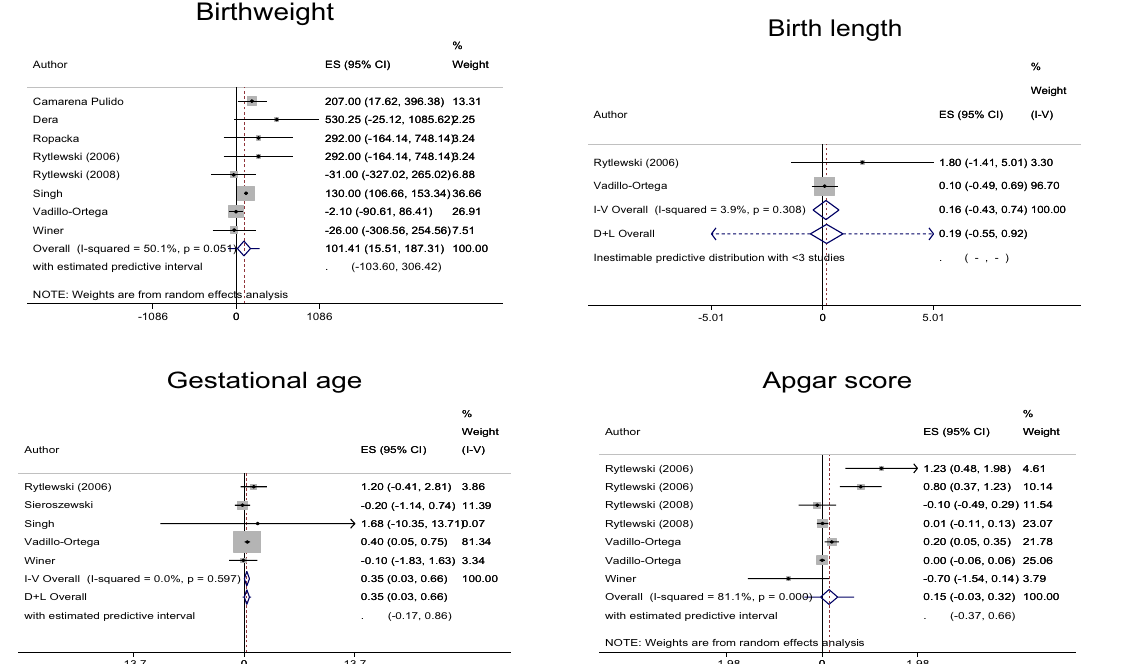
Figure 3. Forest plots of continuous birth outcomes. D + L, DerSimonian & Laird; I-V, inverse variance. The model of DerSimonian & Laird is used when D + L or I-V is not attached to ‘Overall’. In comparison to controls, the oral l-arginine groups showed significantly increased mean birthweight and gestational age ( n = 8 and 5, respectively) in the total score. However, 95% prediction intervals revealed no guarantee that the effects of l-arginine on IUGR neonates, pre-term birth, RDS and gestational age would be observed in future studies (Figs. 2 and 3). TSA indicated that